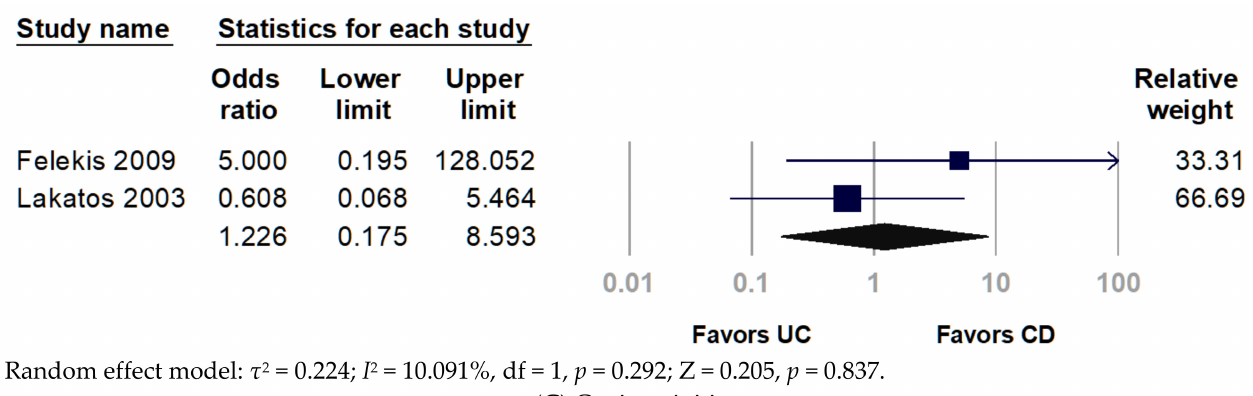
Figure 2. Forest plot for prevalence of ocular extra-intestinal manifestation among adult patients with inflammatory bowel disease: ( A ) uveitis; ( B ) episcleritis; ( C ) conjunctivitis. CD, Crohn’s disease; UC, ulcerative colitis.